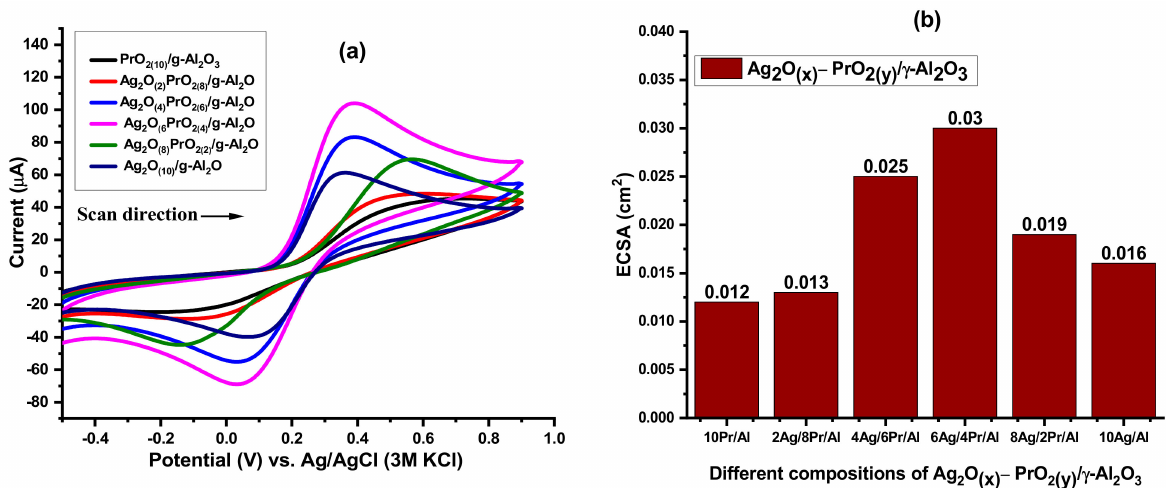
Figure 5. ( a ) Cyclic voltammograms for Ag 2 O ( X ) –PrO 2( Y ) / γ -Al 2 O 3 in K 4 [Fe(CN) 6 ] + 3 M KCl redox solution. ( b ) Bar graph presenting the variation of electrochemical surface area (ECSA) with composition of catalysts.